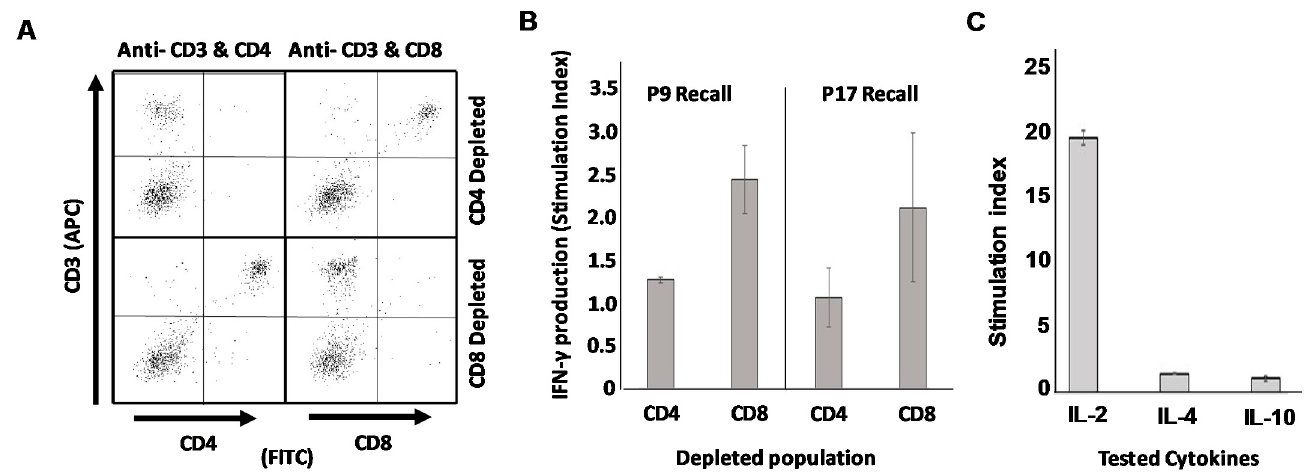
Figure 6. Recall responses to identified peptide epitopes are mediated by CD4 pos T cells and not CD8 pos T cells. Mice immunized with activated DCs pulsed with either p9 or p17 were sacrificed and single cell suspensions made of their spleens 16 days later. Cells were then subjected to magnetic bead separation to remove either CD4 pos or CD8 pos cells from total splenocyte populations. ( A ) Representative quality control FACS analysis of separated cells from p17 vaccinated mice demonstrating successful specific removal of either CD4 pos or CD8 pos populations. ( B ) CD4 pos - and CD8 pos - depleted splenocyte populations were each stimulated in vitro with vaccinating peptides and 24 h supernatants analyzed for IFN- γ production by ELISA. ( C ) Peptide-stimulated 24 h culture supernatants from unfractionated splenocytes of p17-vaccinated mice were analyzed for IL ‐ 2, IL ‐ 4 and IL ‐ 10 via ELISA.